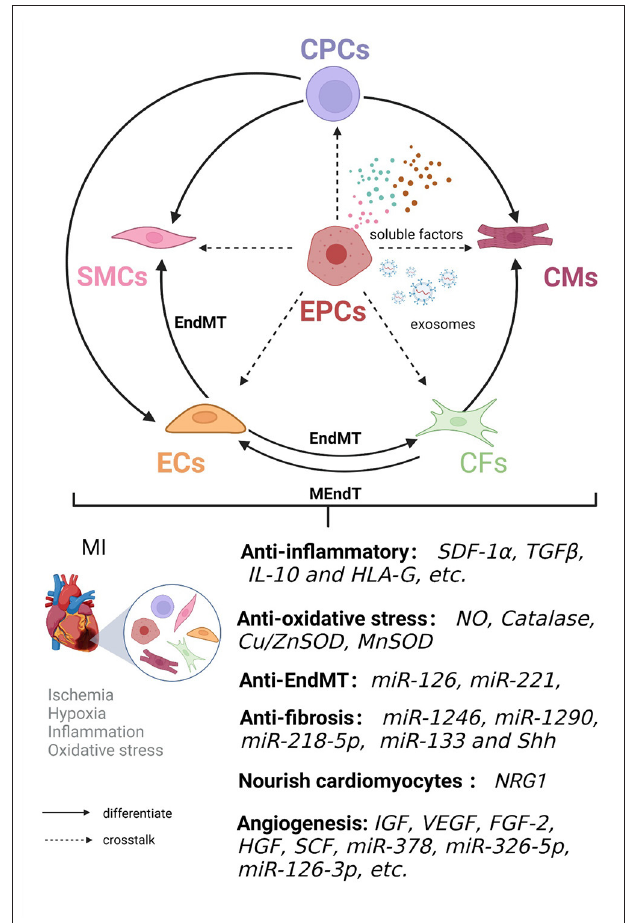
FIGURE 2 | Crosstalk between EPCs and cardiac cell populations is involved in cardiac remodeling and repair in ischemic heart disease. EPCs have the ability to differentiate into endothelial cells in an autocrine and paracrine manner. EPC crosstalk with endothelial cells (ECs), smooth muscle cells (SMCs), cardiomyocytes (CMs), cardiac fibroblasts (CFs), and cardiac progenitor cells (CPCs) can jointly improve the microenvironment in terms of inflammation and oxidative stress and inhibit endothelial-mesenchymal transition (EndMT) and fibrosis, nourish cardiomyocytes and induce angiogenesis, thereby promoting cardiac remodeling and